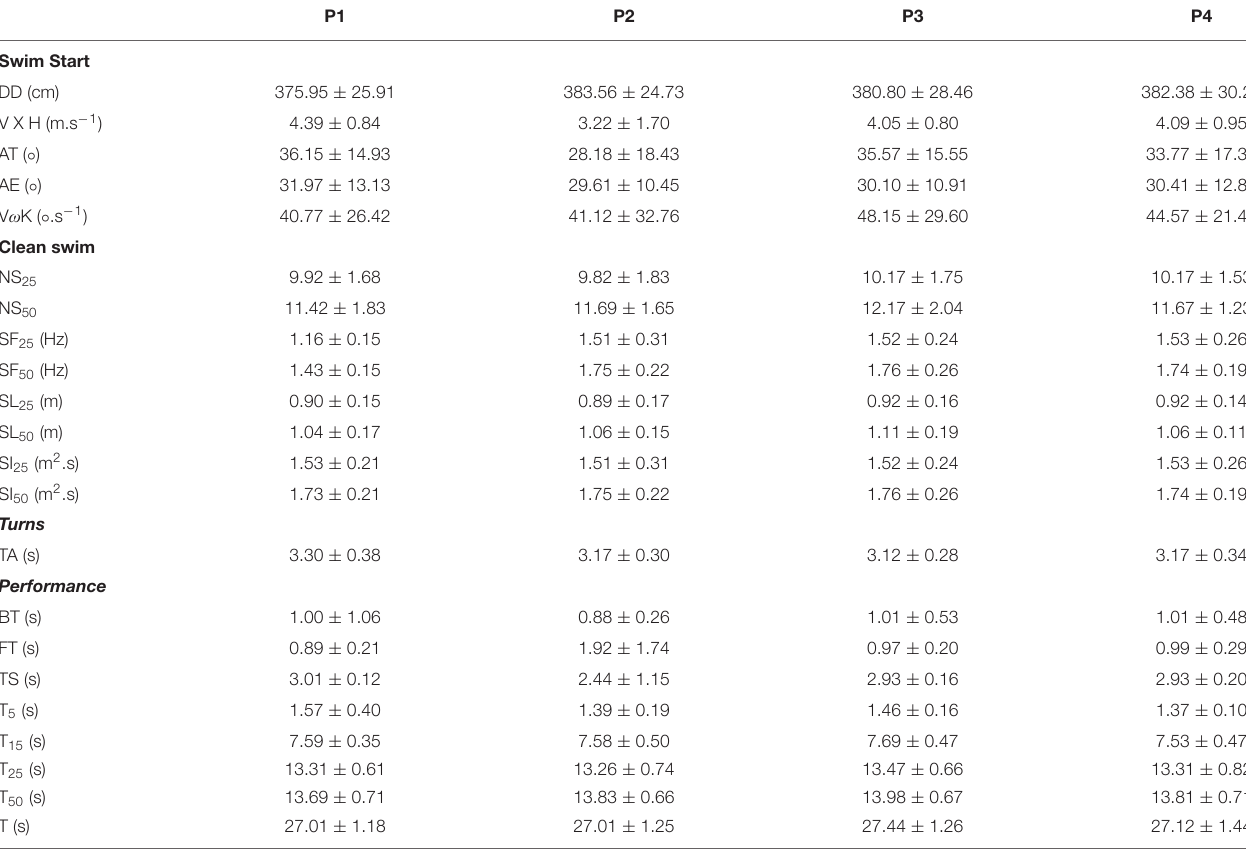
TABLE 2 | Description of the kinematic variables in the swim start, clean swim, turns and performance observed in the different protocols. P1 P2 P3